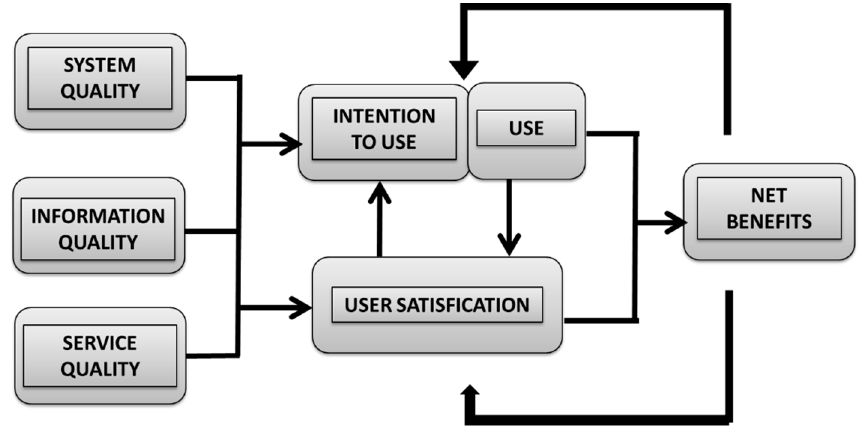
Figure 2. Updated information system success model [7].